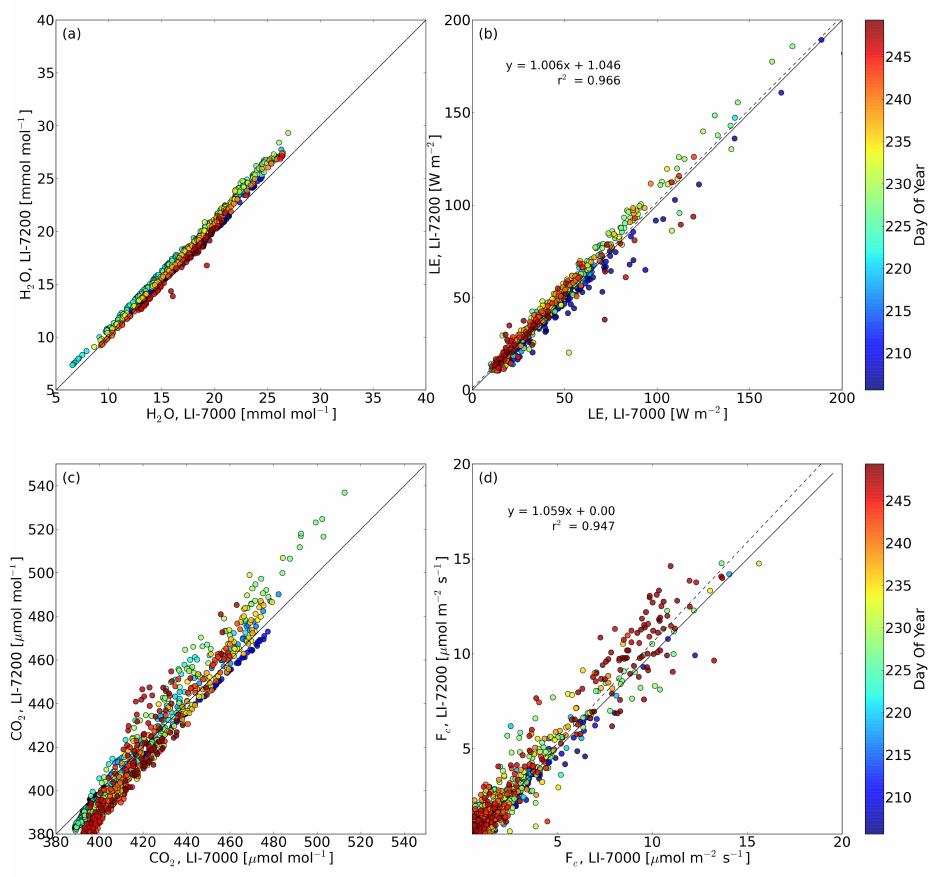
Fig. 8. Comparison of H 2 O (a) and CO 2 (c) mole fractions as measured by the LI-7000 and LI-7200 and corresponding LE (b) and F c (d) fluxes after compensation of concentration biases. Colour represents progressing time from the beginning of the